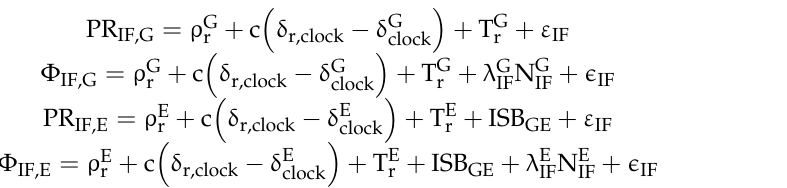
Table 2. Used weighting functions. Functions